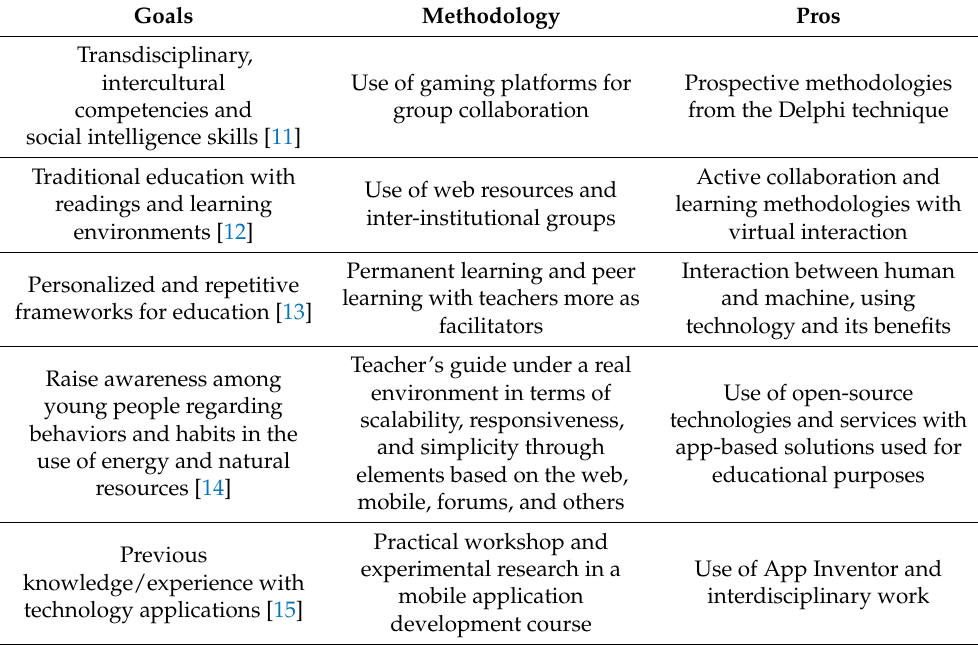
Table 1. Summary of related works on IoT Education